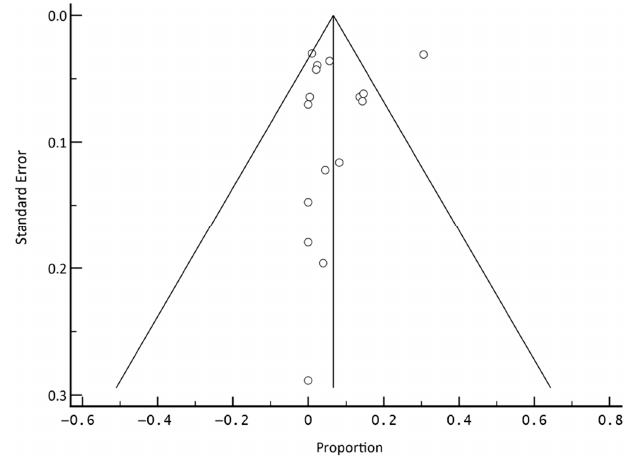
Figure 3 . Funnel plot of the meta-analysis of published studies. Each plotted point represents the standard error and relative frequency for one study. The triangle represents the region where 95% of the data points are located. The vertical line represents the average relative